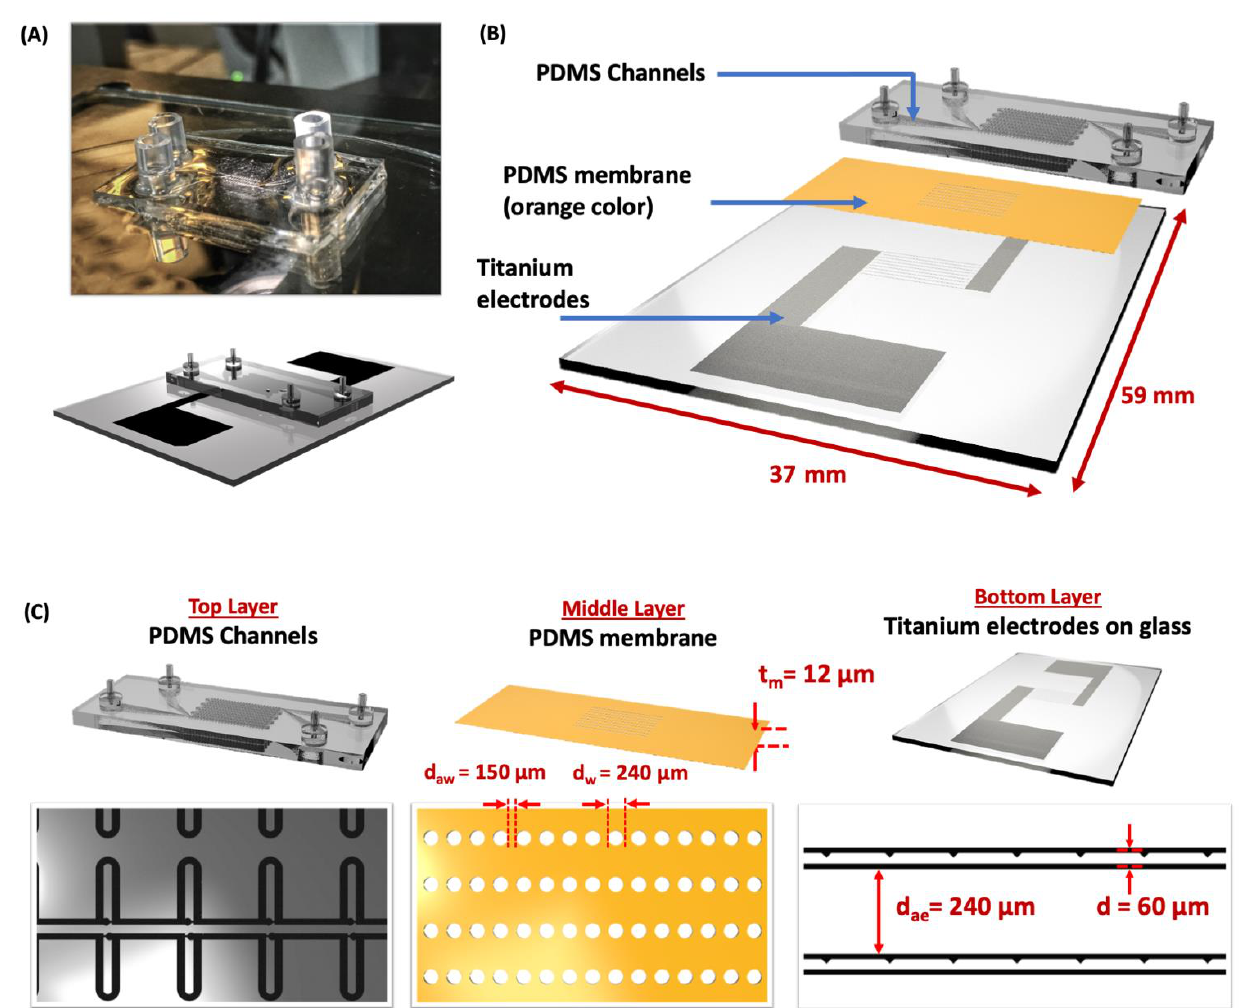
Figure 1. Illustration of Microfluidic Flip-Chip ( A ) Image shows the fabricated MFC using a soft lithography process along with the illustration. ( B ) A graphic illustration of the MFC shows the three-layered structure with PDMS channels as the top layer, through-hole membrane as the middle layer, and titanium electrodes as the third bottom layer. ( C ) The parameters affecting chip performance—the PDMS membrane thickness (t m ), the diameter of fusion well (d w ), the distance between adjacent wells (d aw ), the distance between electrodes (d), and the distance between adjacent electrodes (d ae ) are as shown. Scale bar: 200 µm.